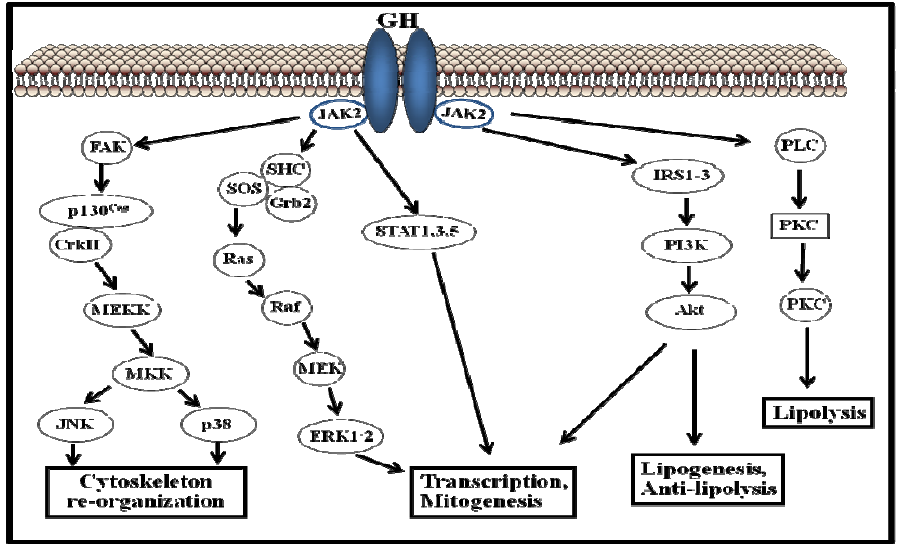
Figure 2. Schematic representation of growth hormone-activated signalling